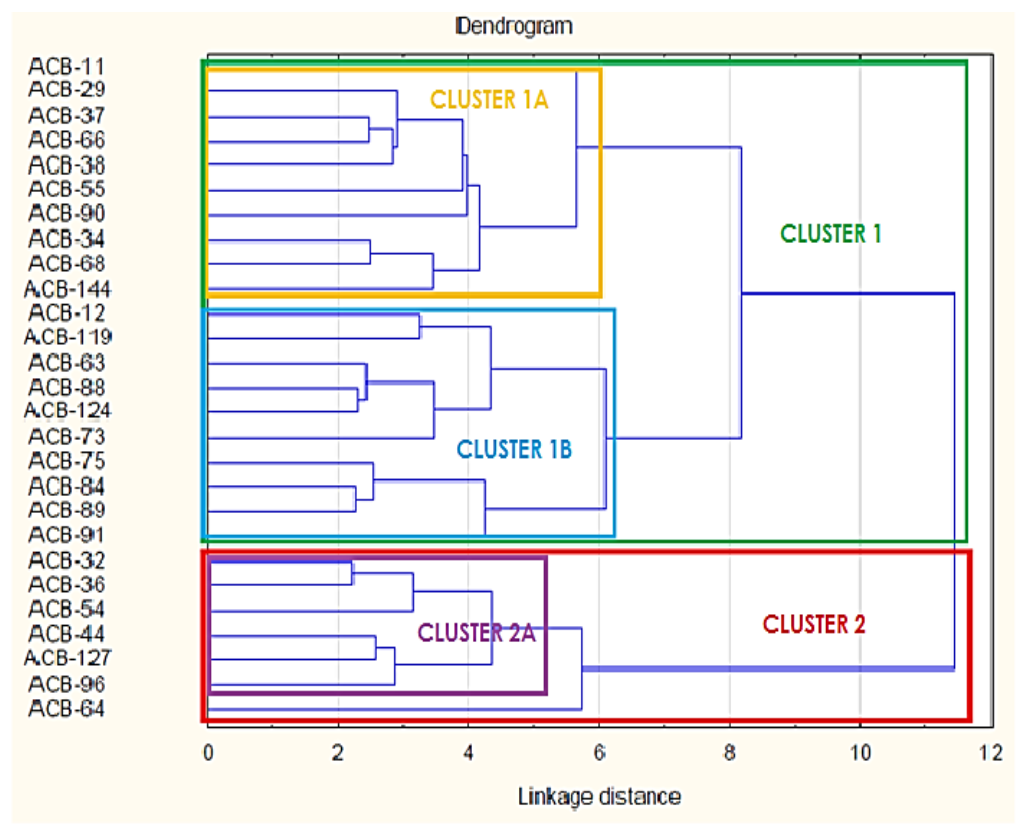
Figure 7. Relationship between ACB Isolates. Bacterial designations are based on sampling origin and biofilm formation ability.